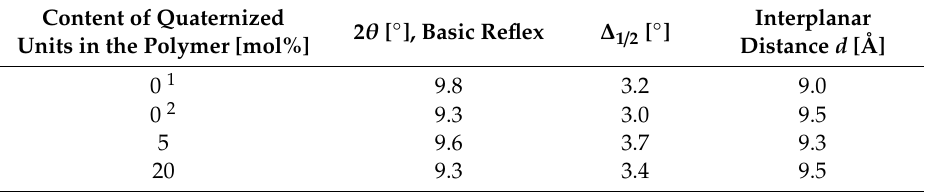
Table 3. Radiographic characteristics of PTMSP samples with different contents of imidazole salt. Content of